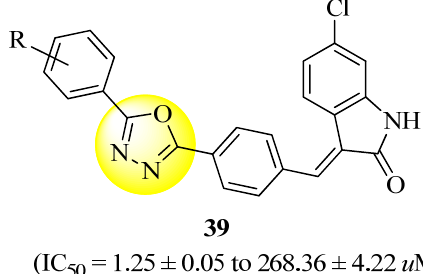
Figure 19. Nitrobenzofuran-1,3,4-Oxadiazoles derivatives.